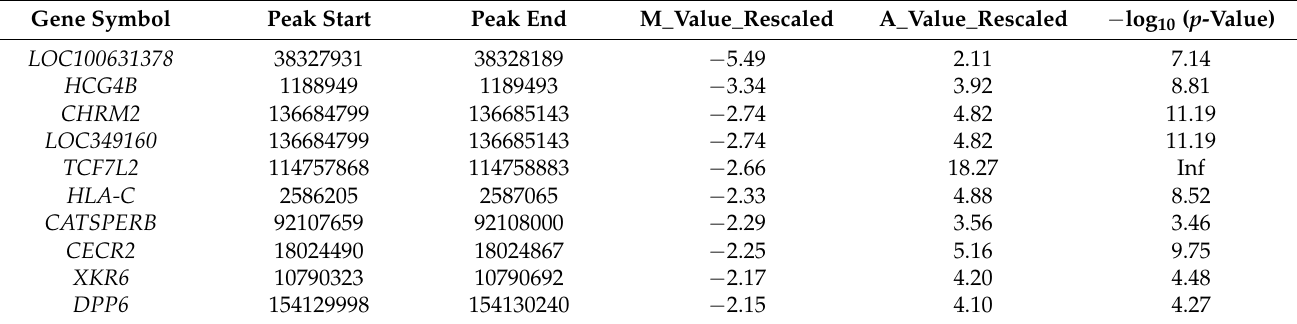
Table 2. Top genetic loci with increased H3K9ac enrichment in atherosclerosis patients with T2D.